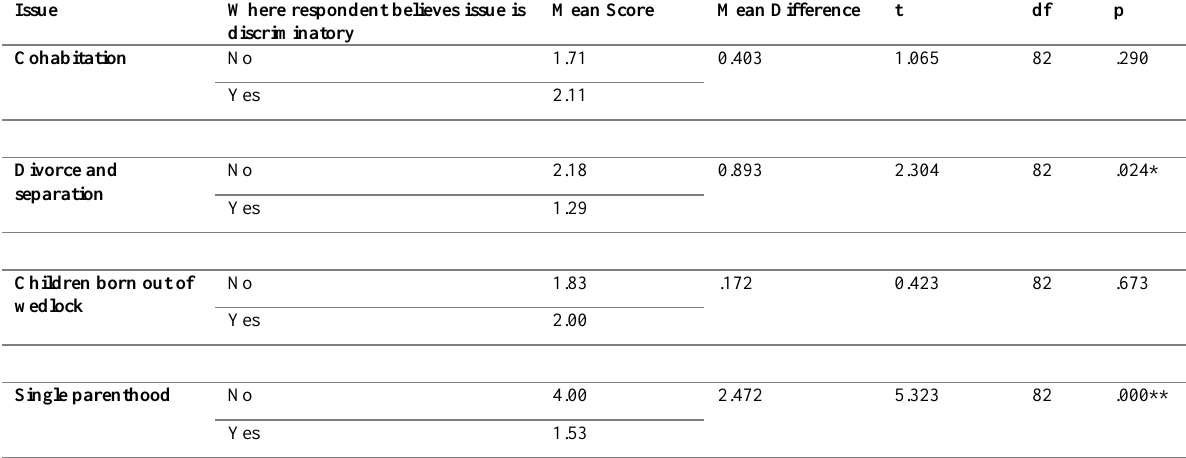
Table 6: Influence of Church Policy about Family Issues on Youth Empowerment